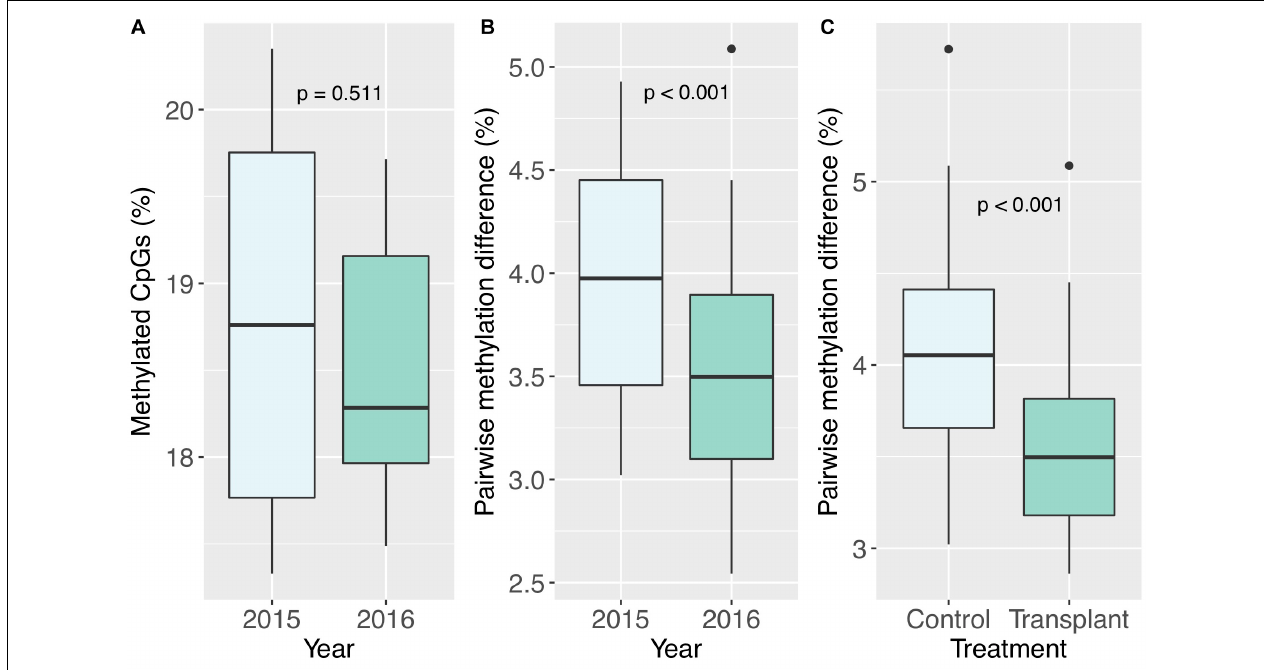
FIGURE 6 | (A) Percent methylated CpGs by year. (B) Pairwise methylation difference by year, including all pairwise comparisons between colonies. (C) Pairwise methylation differences by treatment, including comparisons of transplanted corals to the two controls, and transplanted corals to the transplanted counterparts of the two controls (pa5 and